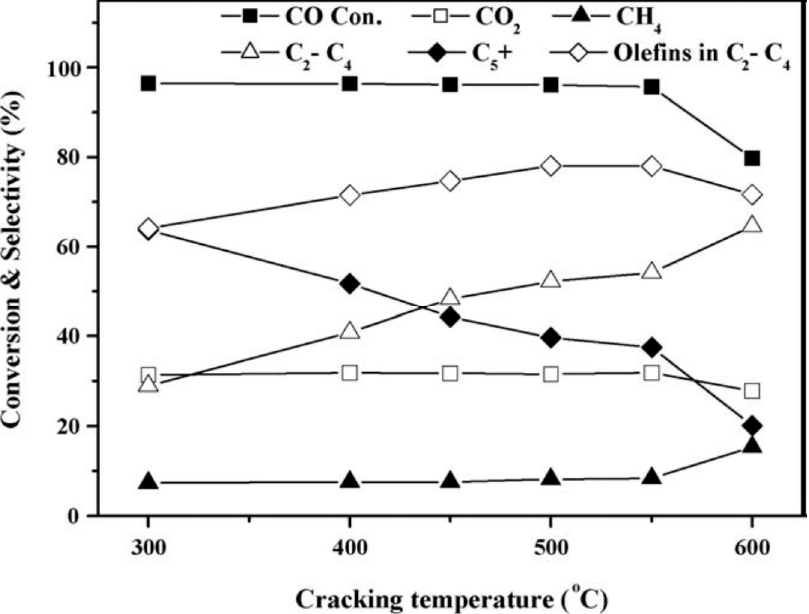
Figure 21. Effect of cracking reaction temperature on product selectivity. Reprinted with permission from [95]. Copyright (2009) Elsevier Science Inc., New York, America.